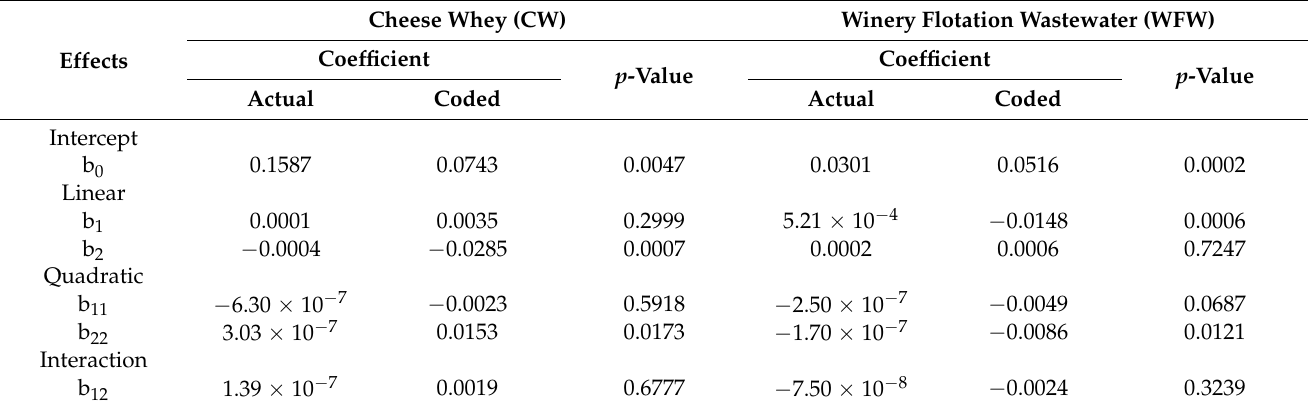
Table 6. Coefficients of regression equations for settling